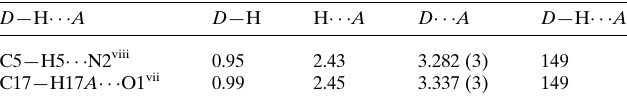
Table 1 Hydrogen-bond geometry (A˚ , (cid:4) ).